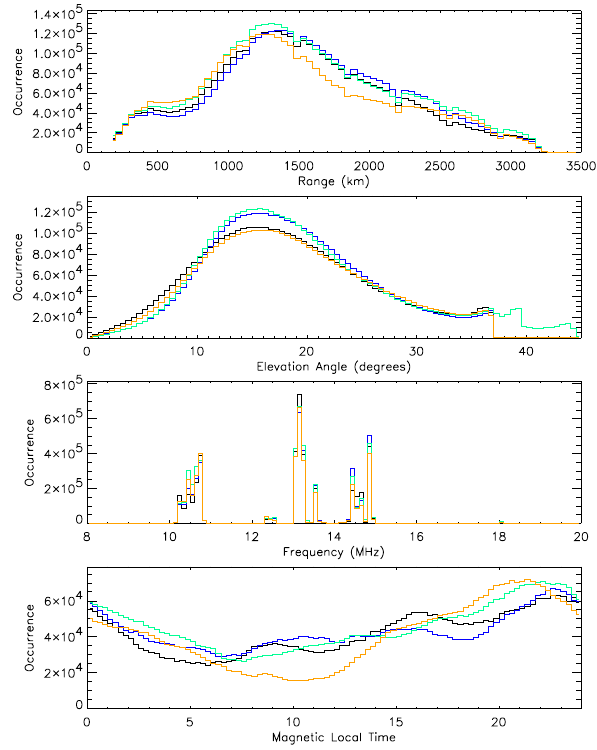
Fig. 10. Statistical histograms of range, elevation angle, frequency, and magnetic local time for common mode data from four differ- ent Saskatoon beams from 1997–2001 inclusive. The black, blue, green, and yellow curves show the histograms for beams 3, 6, 9, and 12,